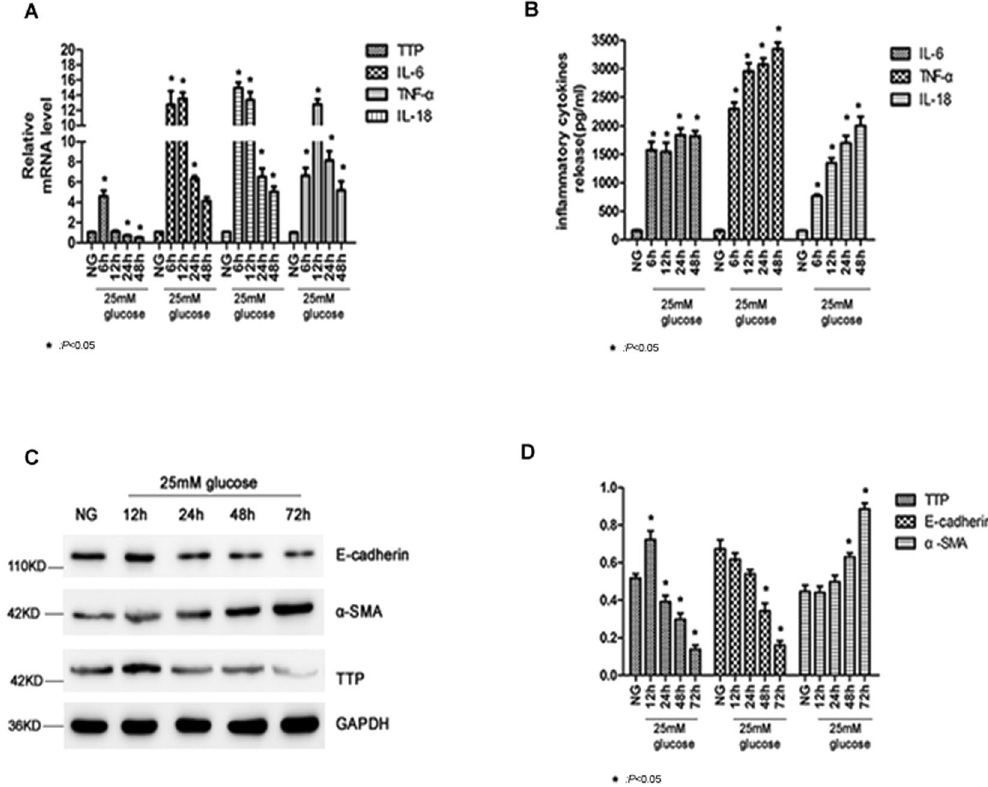
Figure 9. The Expressions of Renal Tubular Epithelial Cells Exposed to High Glucose. ( A ) The mRNA expressions of TTP, IL-6, TNF- α and IL-18. ( B ) The expression of inflammatory cytokines. ( C ) Western blot result regarding the expressions of TTP and transition-related proteins in renal tubular epithelial cells. ( D ) The expressions of TTP and transition-related proteins in renal tubular epithelial cells. * P < 0.05 compared with control.